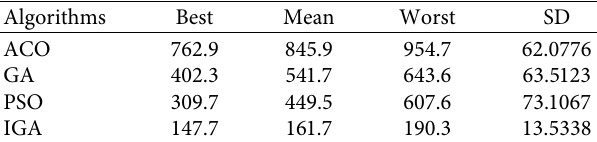
Table 6: Comparison of various statistical values by the applied algorithm.